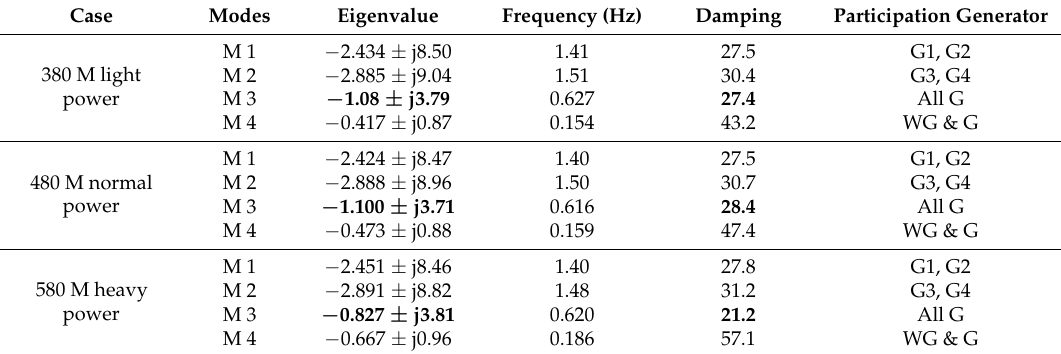
Table 6. The oscillation modes with PSSs and PODs.